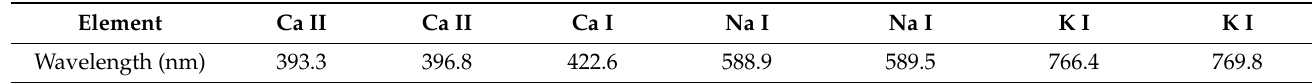
Table 2. Three metal elements and their wavelengths in the experimental samples.